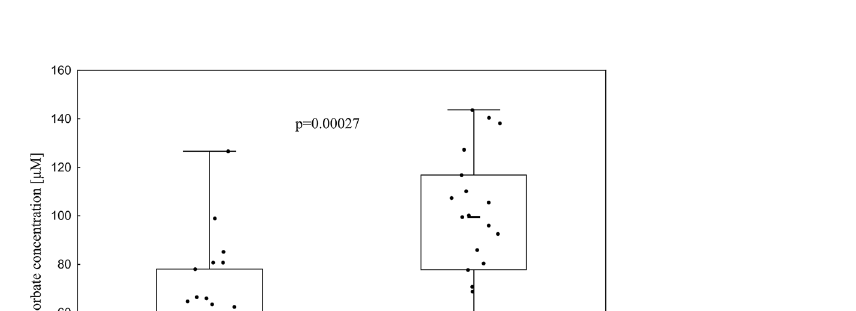
Table 4. Expression of TET1, TET2 and TET3 protein in the lymphocytes of healthy controls and ALL patients ( * p < 0.05).